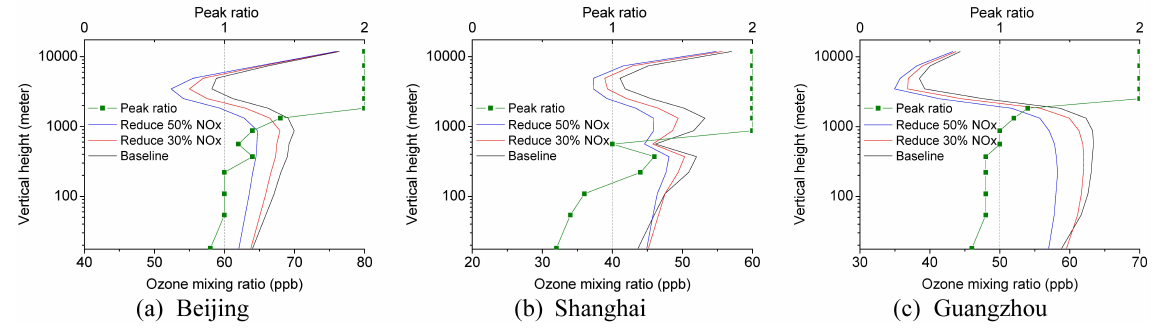
Fig. 9. Vertical profile of peak ratio and ozone mixing ratio in Beijing, Shanghai and Guangzhou (monthly mean of daily 1-h maxima, July 2005). The ozone response varies with vertical distance as